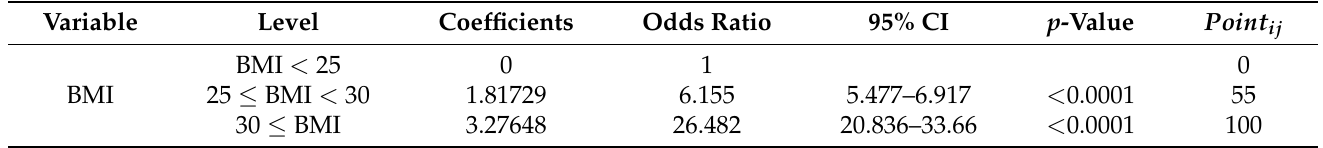
Table 2. Multiple logistic regression analysis results about metabolic